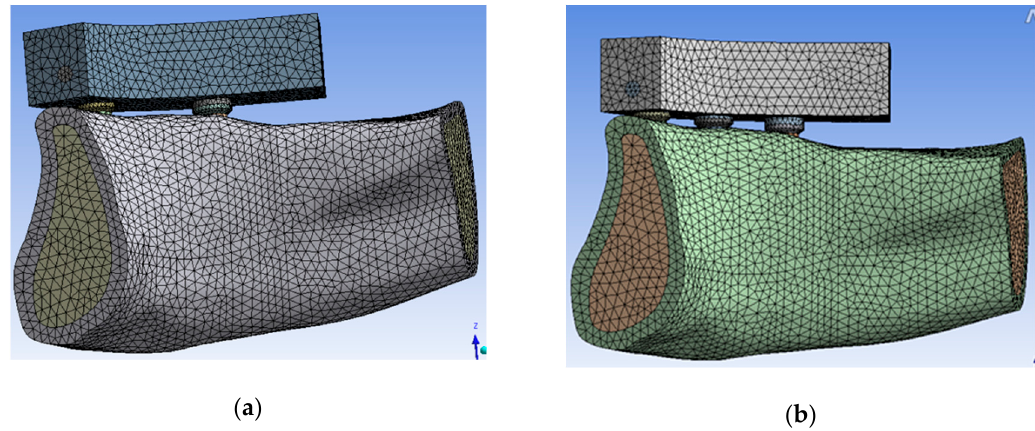
Figure 4. v on Mises stress on the implant, abutment, and metallic structure: (a) group M1; (b) group M2.